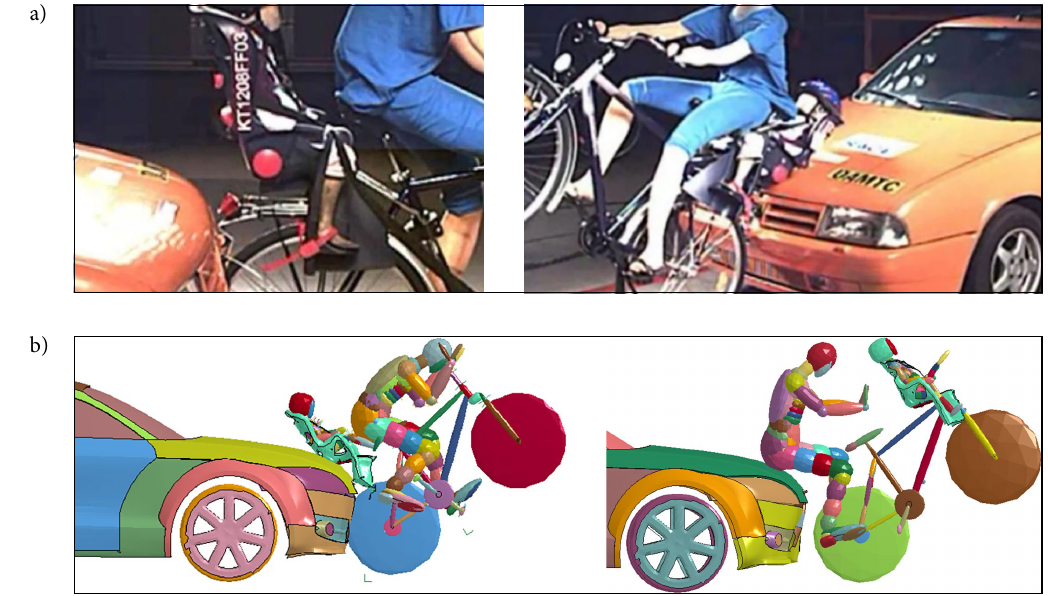
Figure 5. Rear-end crash: a – full-scale test performed by ADAC (2008); b – authors’ original simulations for rear and front mounted child